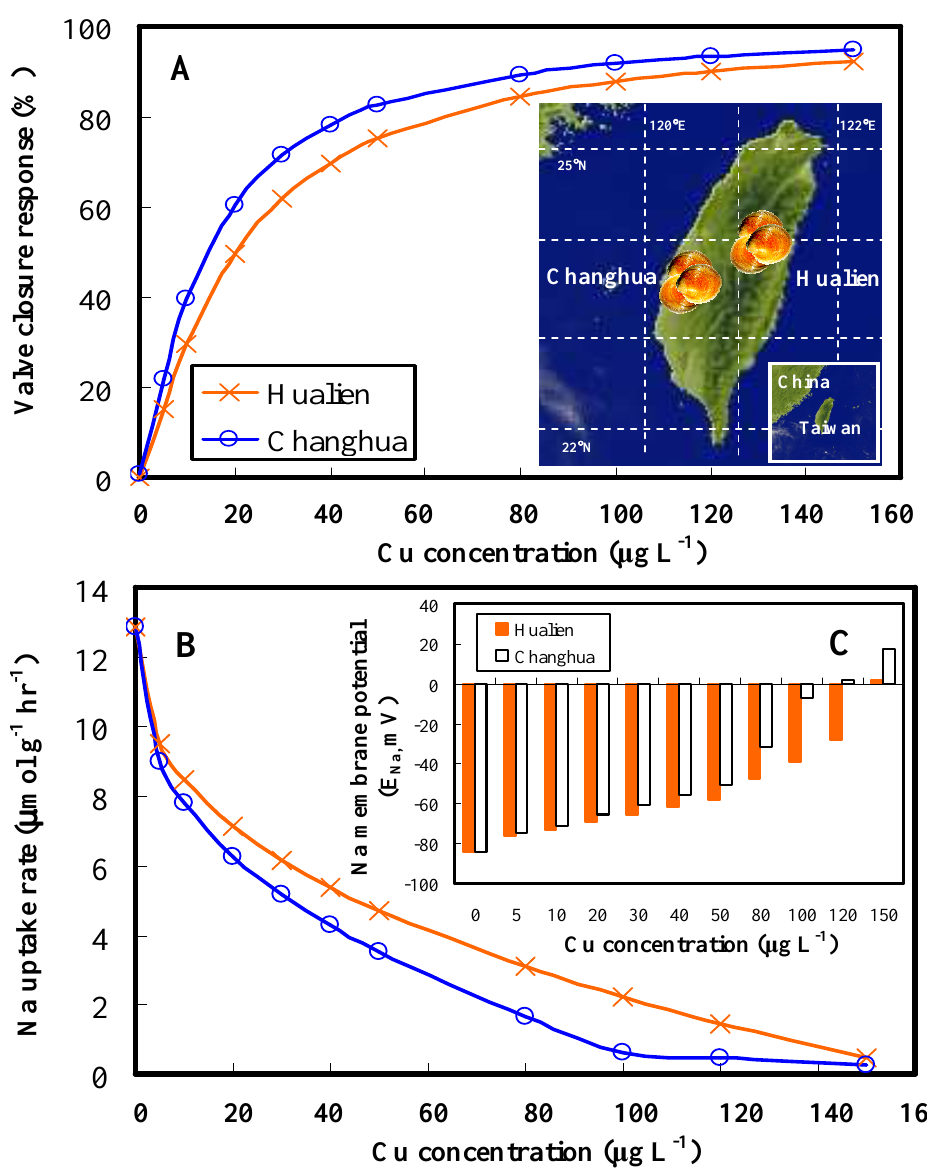
Figure 6. Simulations of freshwater clam C. fluminea physiological and electro- physiological characteristics in response to waterborne Cu for major clam farms located at Changhua and Hualien, showing the site-specific toxicity effect of (A) valve closure response, (B) Na uptake rates, and (C) Na membrane potentials varied with Cu concentrations ranging from 0 - 150 m g L -1